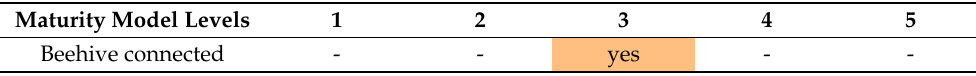
Table 4. Maturity Model levels of the case